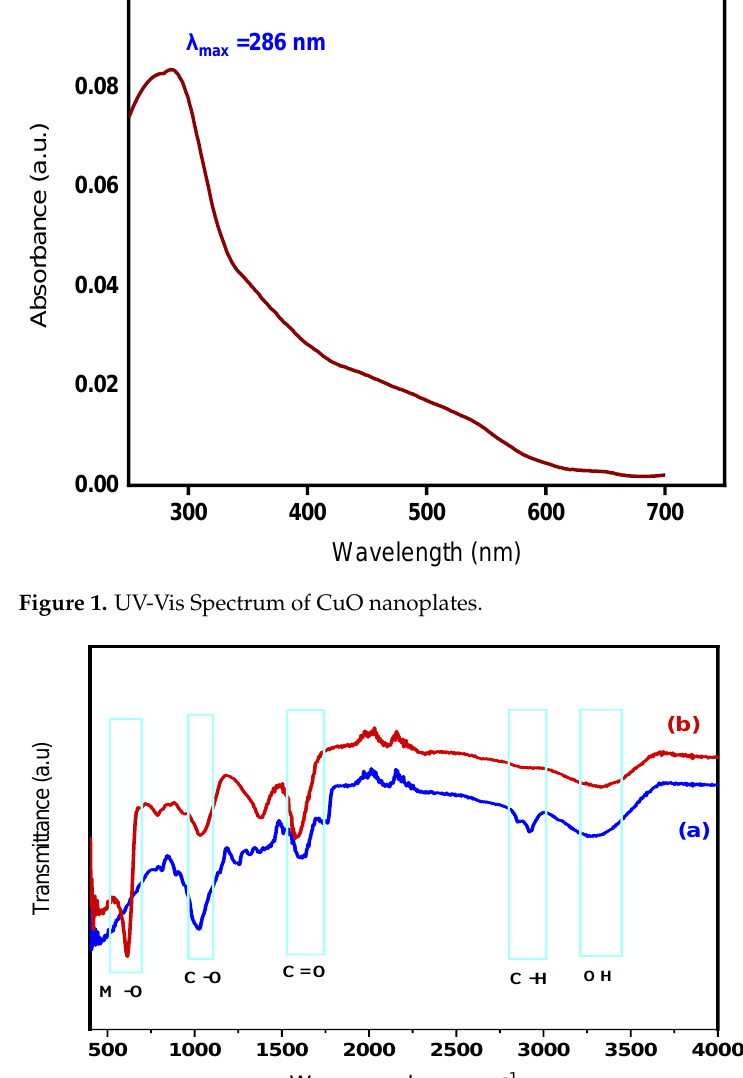
Figure 1. UV-Vis Spectrum of CuO nanoplates.